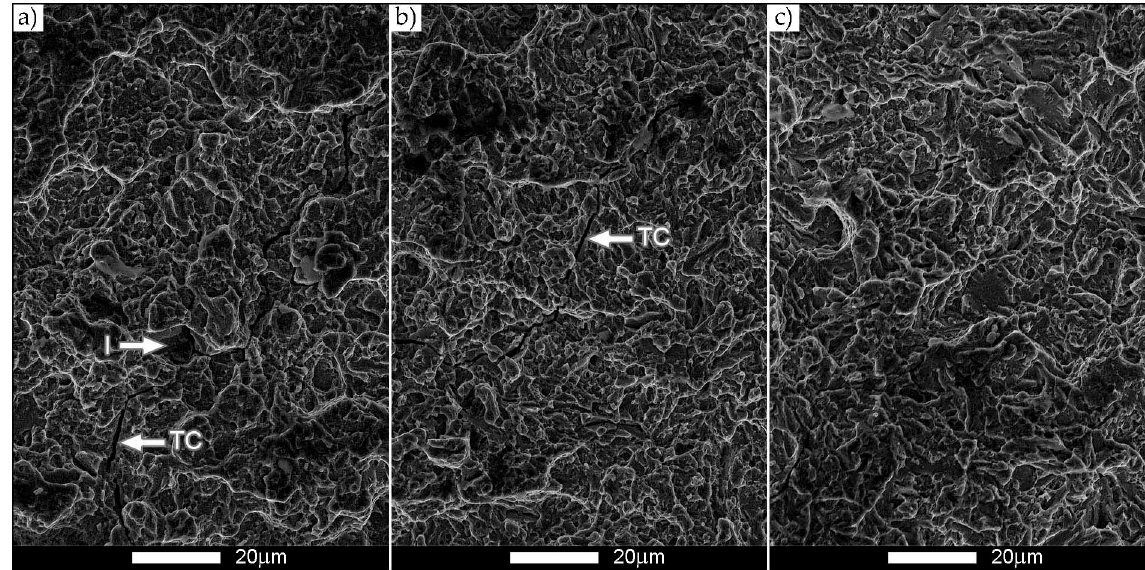
Figure 14. Images of the Hardox Extreme steel fracture surface in delivery state shown in Figure 9: transverse orientation ( − 40 °C). ( a ) The area marked with the A1 frame. ( b ) The area marked with the B1 frame. ( c ) The area marked with the C1 frame. I—inclusions, voids left after debonded inclusions, TC—transversal cracks. SEM, non-etched state.